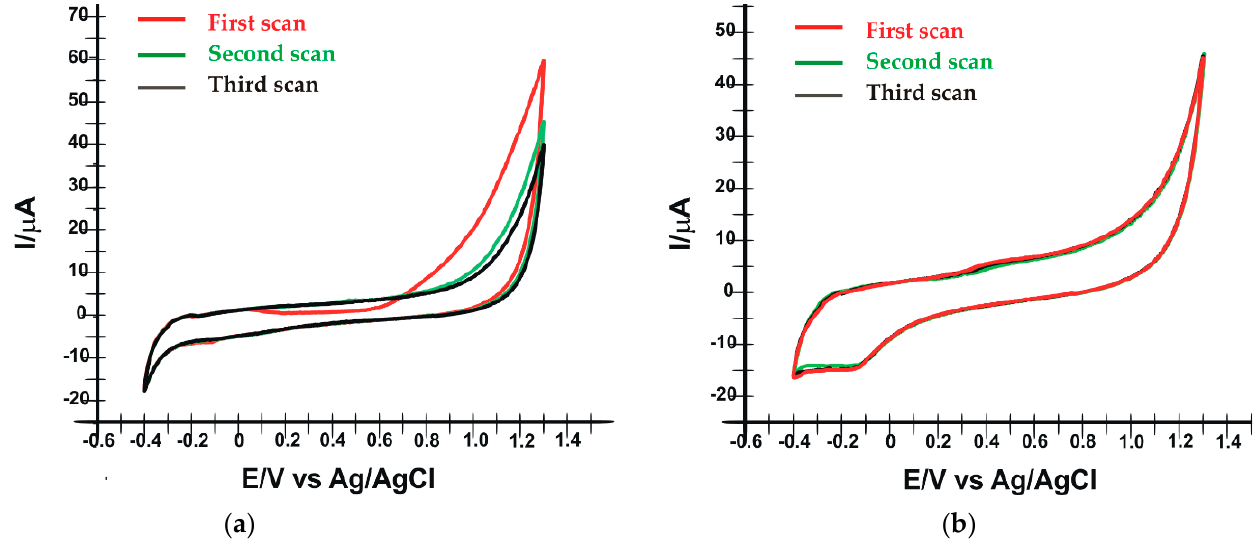
Figure 1. Cyclic voltammograms recorded in 10 − 1 M PBS solution, by the SPE/SWCNT/Lac at pH 5.0 ( a ) and SPE/SWCNT/Tyr at pH 7.0 ( b ). Scan rate 0.1 V·s − 1 . pH 5.0 ( a ) and SPE/SWCNT/Tyr at pH 7.0 ( b ). Scan rate 0.1 V · s − 1